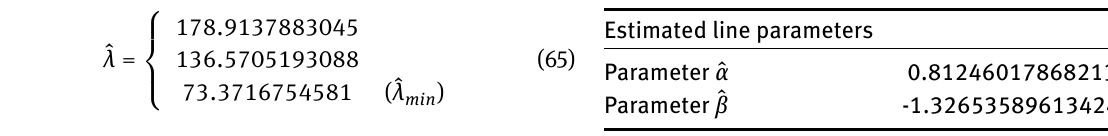
Table 8: TLS solution - line fit